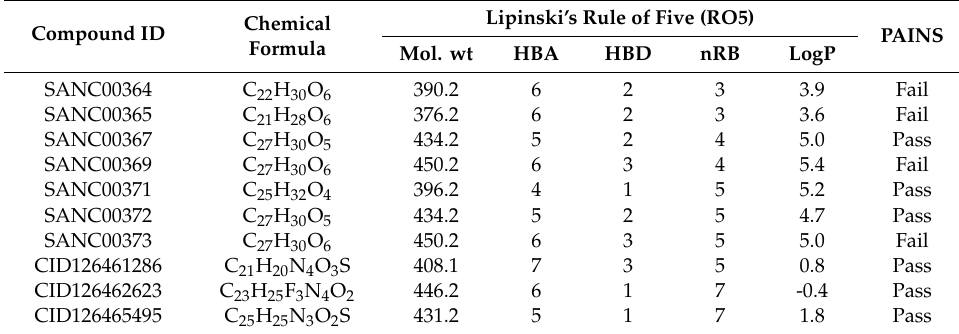
Table 1. Drug-like properties and pan assay interference compounds (PAINS) filtering of identified hits from the SANCDB and analogs from the PubChem